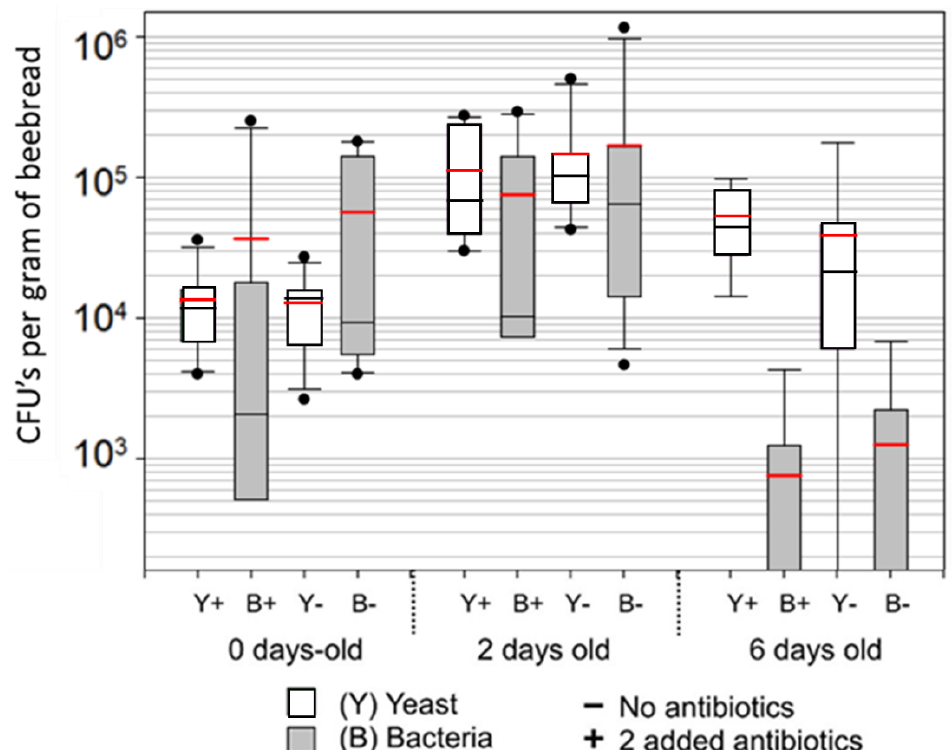
Figure 3. Culture dependent results from colony build-up during spring bloom. Using a dilution series, and Sabouraud dextrose agar, we cultured fungal and bacterial growth from fresh corbicular pollen (0 days old) and pollen stored for 2 or 6 days. Box plots display variation in microbial growth across 13 colonies sampled over 6 days. The red line is the mean, black the median, boxes are at 25% and 75%, whiskers at 5% and 95%, and the dots are outliers. Samples were cultured with (+) and without ( − ) the addition of antibiotics chloramphenecol and ceftazidime. Following growth, microorganisms (CFUs) were exhaustively identified as bacteria (grey) or yeast (white) using light microscopy.